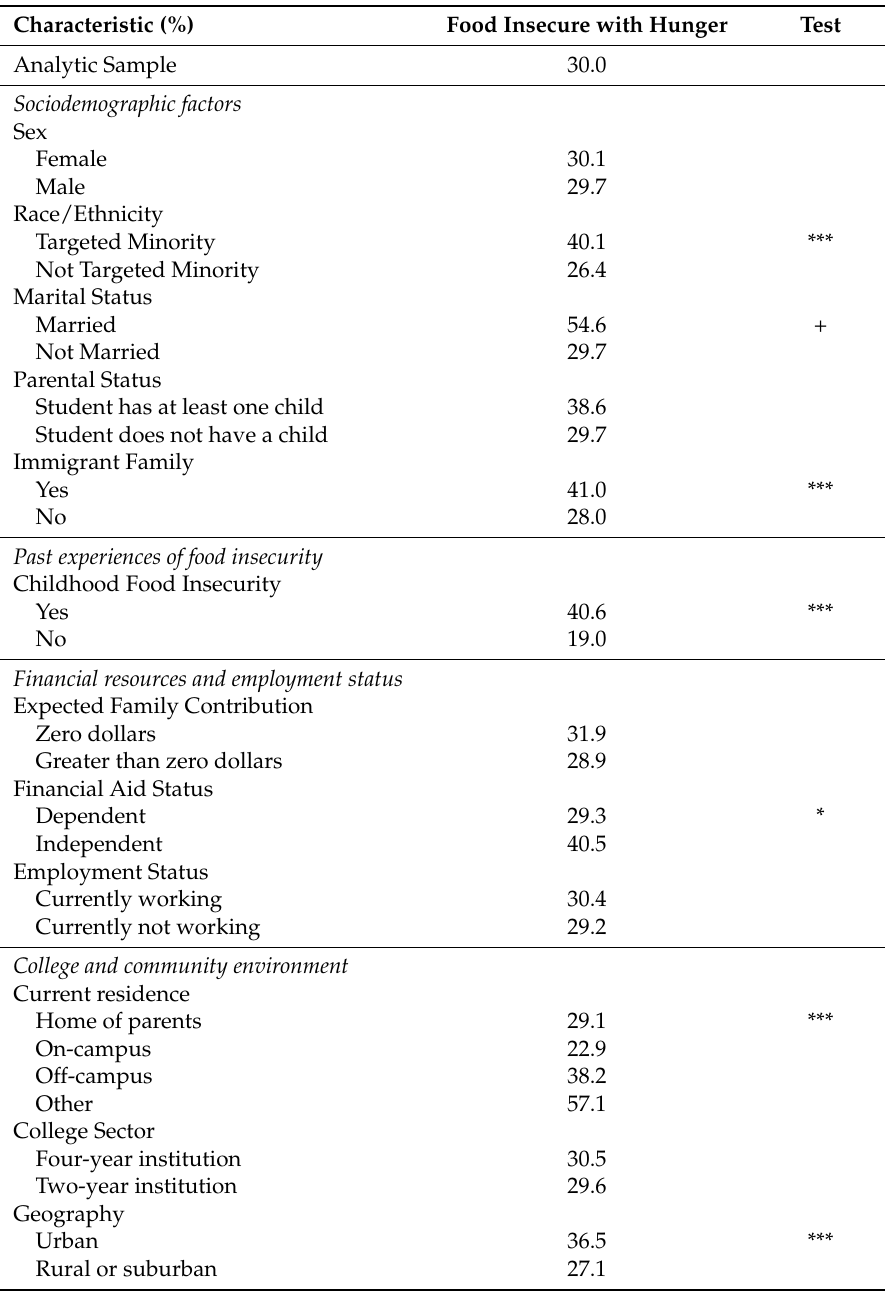
Table A2. Food insecurity with hunger by